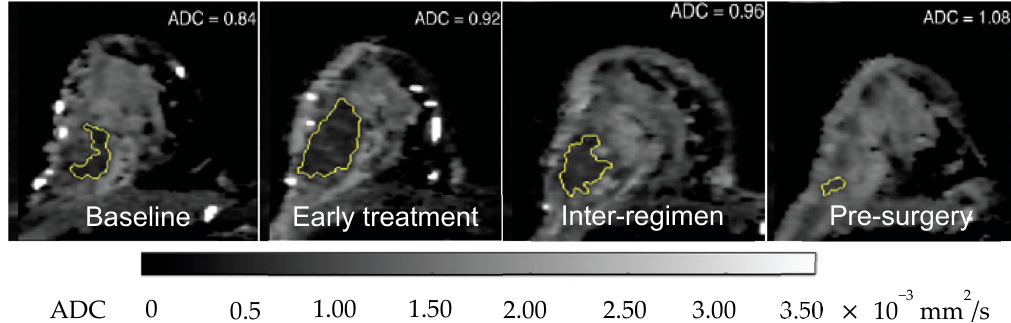
Figure 5. An example of an HR +/ HER2 − breast cancer patient who had neoadjuvant chemotherapy being monitored by MRI. The serial apparent di ff usion coe ffi cient (ADC) maps, obtained from di ff usion-weighted (DW) MRI (b = 800 mm 2 / s), show an increase in value with treatment. Compared to baseline, ∆ ADC = + 9.5% at early treatment; + 14% at inter-regimen and + 29% at